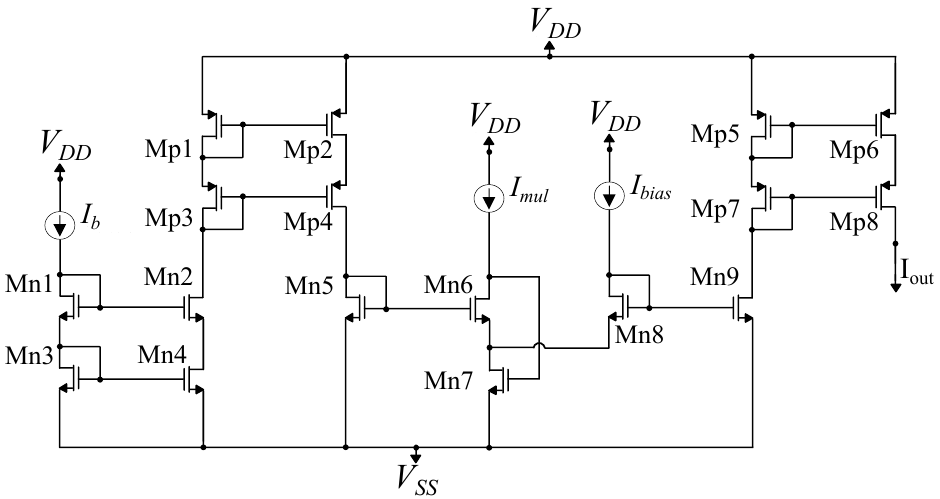
Figure 6. Analog multiplier circuit. To achieve accurate linear scaling, the output current of each multidimensional bump circuit is connected to this analog multiplier circuit. This implementation is based on the translinear